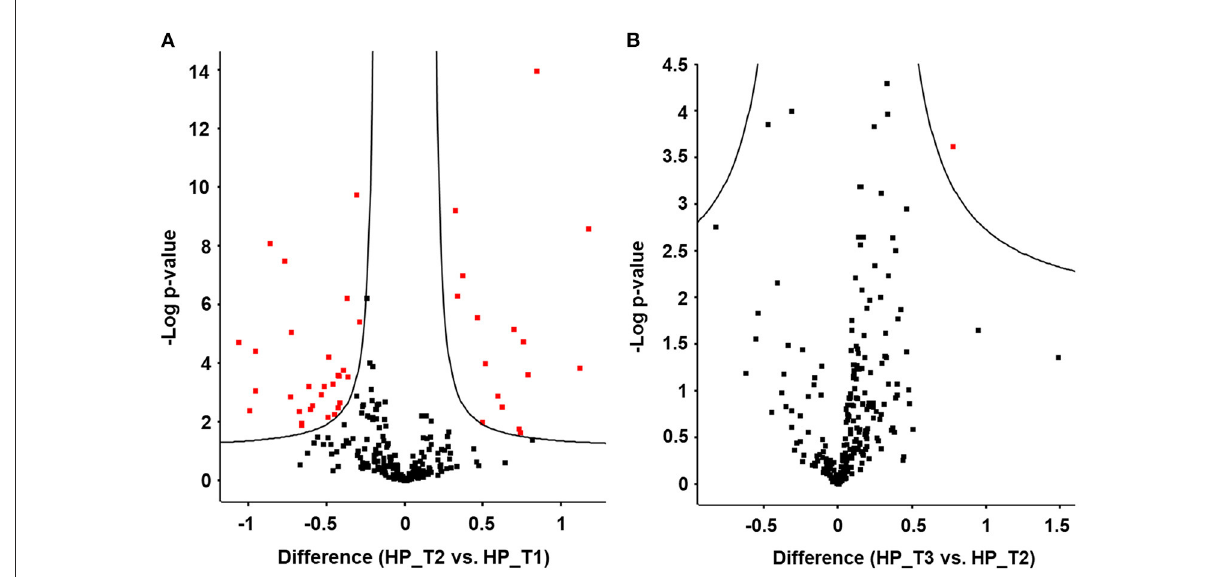
FIGURE5 Plasma proteome analysis reveals significant changes in protein abundance upon high protein diet (HP). Volcano plots display significant protein changes (red) upon (A) high protein diet between T1 and T2 and upon (B) resistance training between T2 and T3 in the HP group. Volcano plots visualize results from unpaired t -test statistics. Differences are plotted as logarithmic values to the basis of